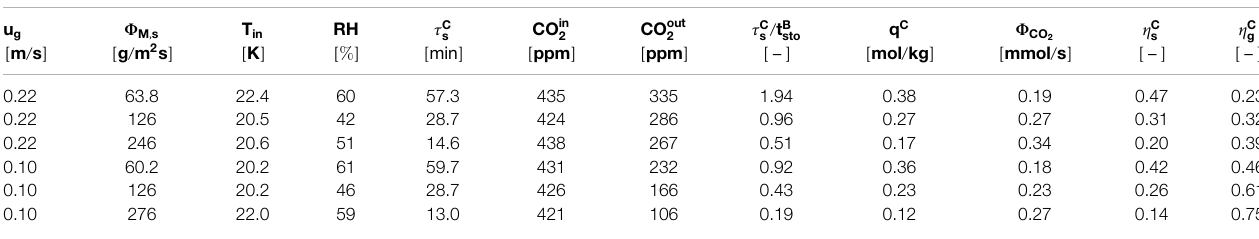
TABLE 2 | Experimental conditions and results for moving bed